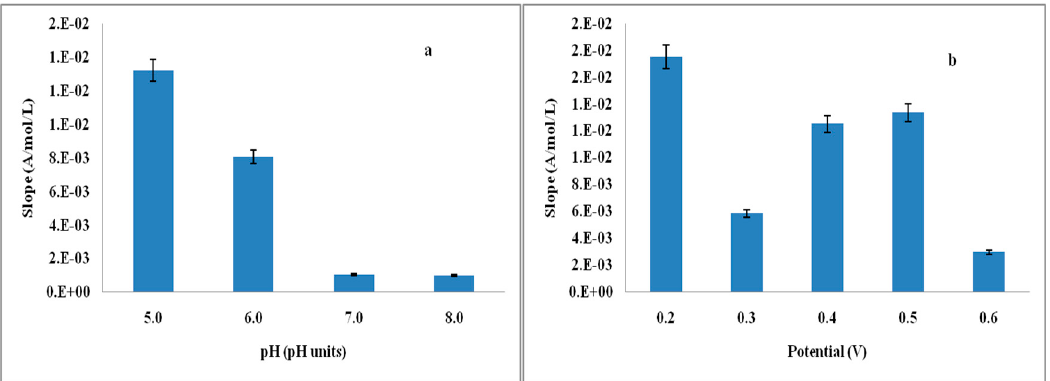
Figure 2. ( a ) Slope values of Al(III) calibration curves with pH; and ( b ) Slope value of Al(III) calibration curves with applied potential. [EPI] = 1.6 × 10 − 4 M; Britton Robinson buffer pH 5.0, Eap = +0.2 V vs. Ag/AgCl.